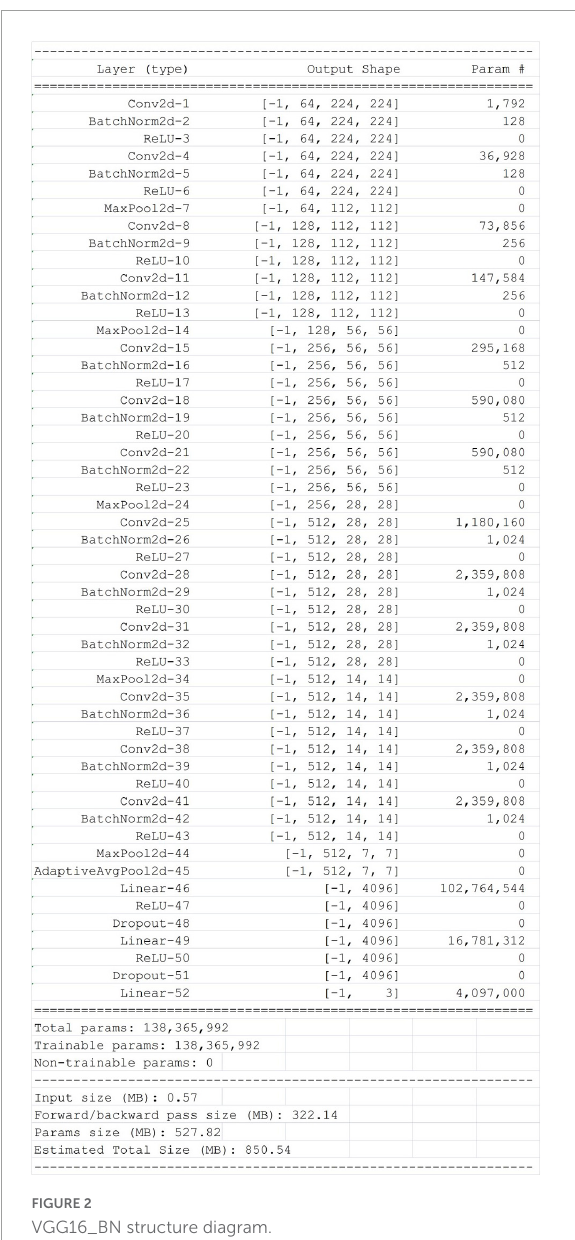
FIGURE2 VGG16_BN structure